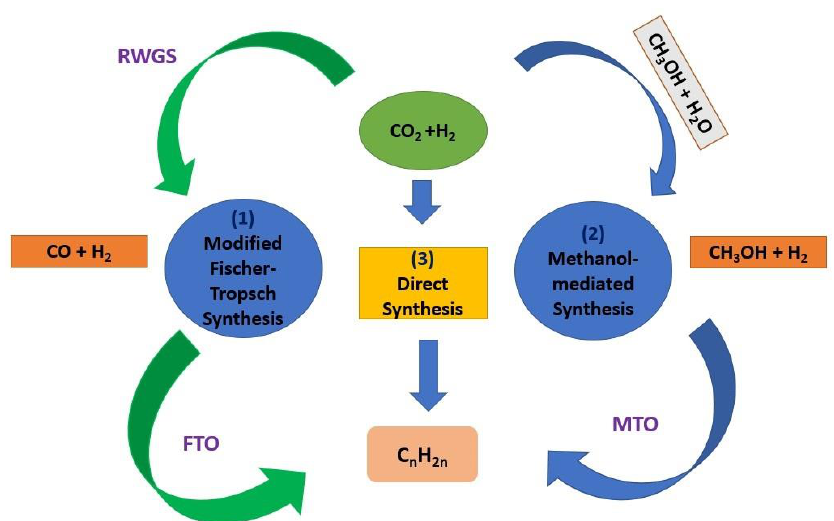
Figure 8. Schematic diagram illustrating the three major pathways for producing olefins from CO 2 : (1) modified Fischer-Tropsch to olefins (FTO) route; (2) methanol to olefins (MTO) route; and (3) direct olefin formation over multifunctional, promoted catalysts. RWGS—reverse water-gas shift. Adapted from